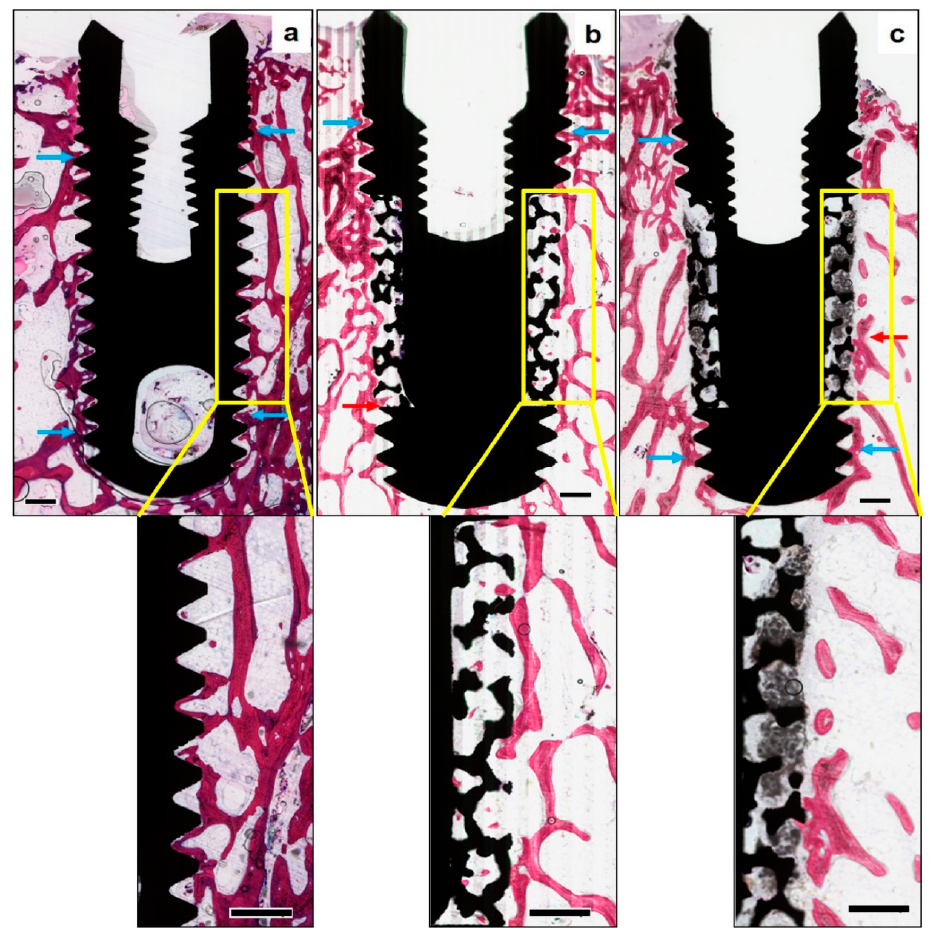
Figure 4. Histomorphometrical assessment of bone formation around the implants—(Methylene blue—basic fuchsin stain, original magnification × 10)—Representative non-decalcified histological sections of the three study groups, ( a ) solid titanium implant (STI), ( b ) porous titanium implant (PTI), and ( c ) porous titanium implant with biphasic calcium phosphate (PTI + BCP), revealing new bone formation around all the implant surfaces along with certain areas of intimate bone to implant contact (blue arrows). Bone ingrowth in the PTI implant (red arrow) is seen up to the inner aspect of the porous structure. BCP granules are seen filling the entire thickness of the porous structure in the PTI + BCP implant, along with evidence of new bone formation and resorption of BCP only in the peripheries (red arrow) and without any signs of BCP resorption in the inner aspect. The “Yellow box” inset is the region of interest (original magnification × 25), measuring 5 mm long by 1000 µ m in height, along with the middle third of the implant surfaces. (Scale bars = 0.5